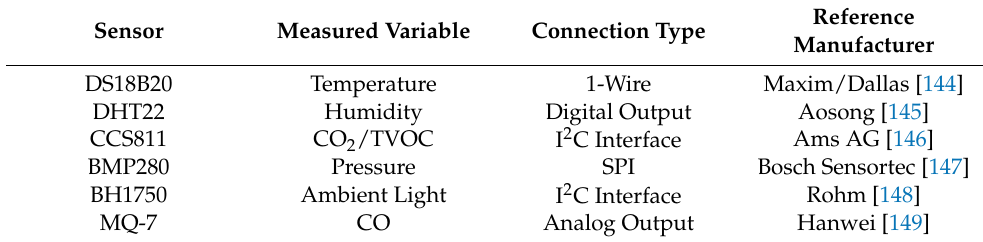
Table 8. Low-cost sensors used in experimental framework.